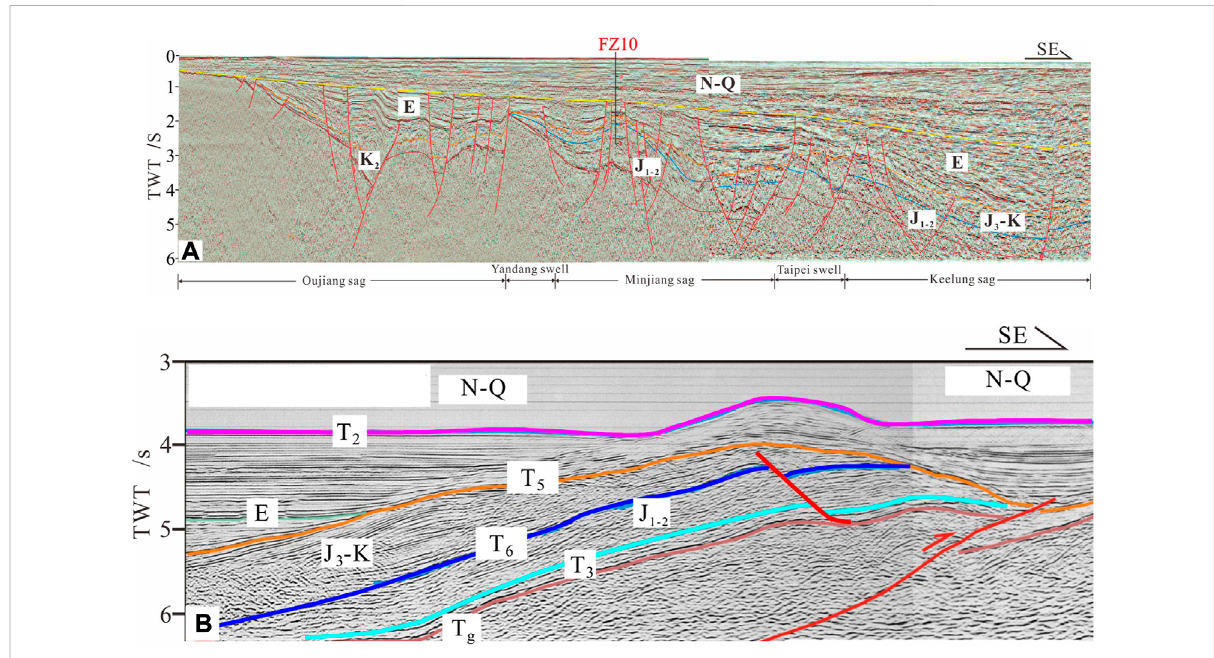
FIGURE 2 SeismicinterpretationofSEorientedpro fi lesshowingthedistributionofsedimentarystrataalongtheSECS (A) andNSCS (B) .T 3 labelrepresents the Late Triassic; J 1-2 represents the Early – Middle Jurassic; J 3 -K represents the Late Jurassic – Cretaceous; E represents the Paleocene; N-Q represents the Neocene – Quaternary; T 2 represents the boundary between the Neogene and Paleogene; T 5 represents the boundary between the